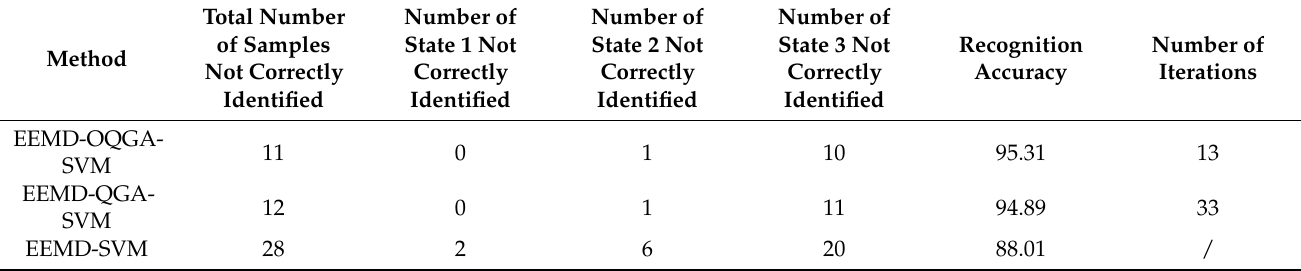
Figure 15. The result diagram of main pump health state identification based on EEMD-SVM. The accuracy rates and number of iterations of main pump state recognition algorithms Table 2. Comparison of state identification results of main